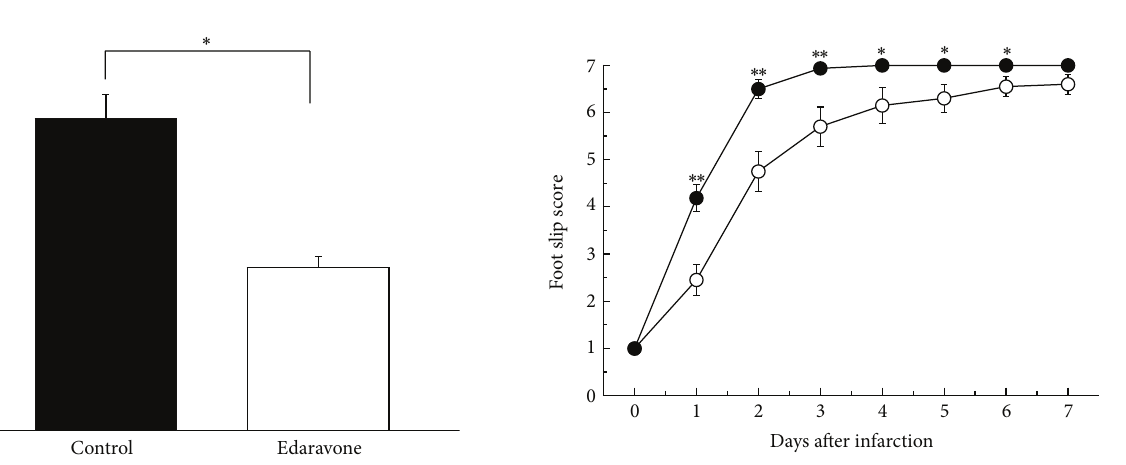
Figure 2: Areas of infarction 7 days after photochemical infarction ( ∗ 𝑃 < 0.01 ).